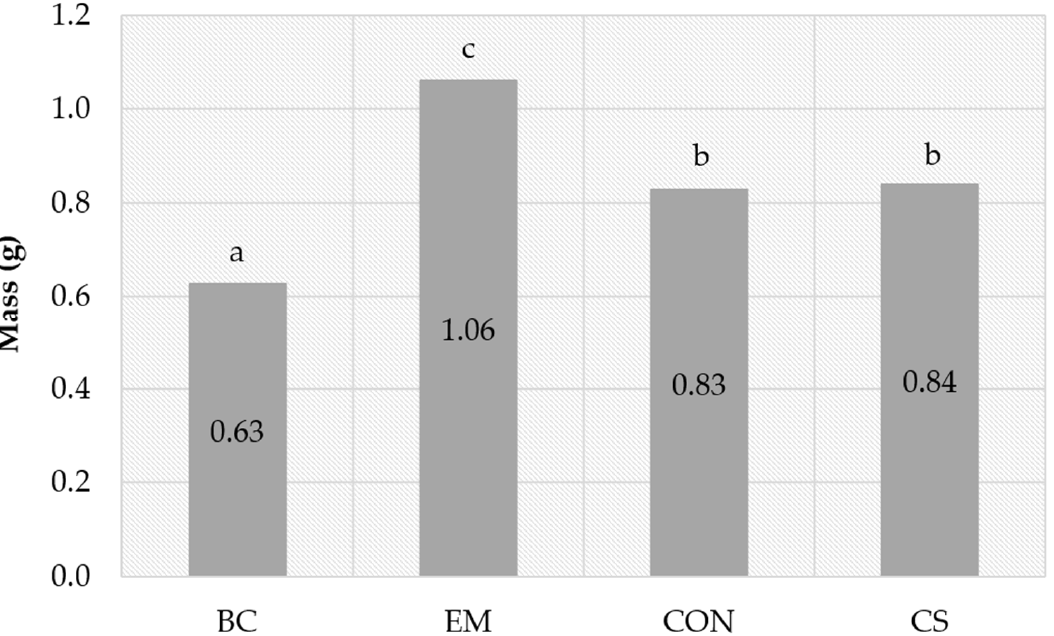
Figure 5. One shoot mass of Chinese cabbage related to plant growth test of three different composts (BC, EM, and CON) in comparison to commercial substrate (CS). Same letter on the bar indicates no statistical differences between composts (Duncan test, p < 0.05).